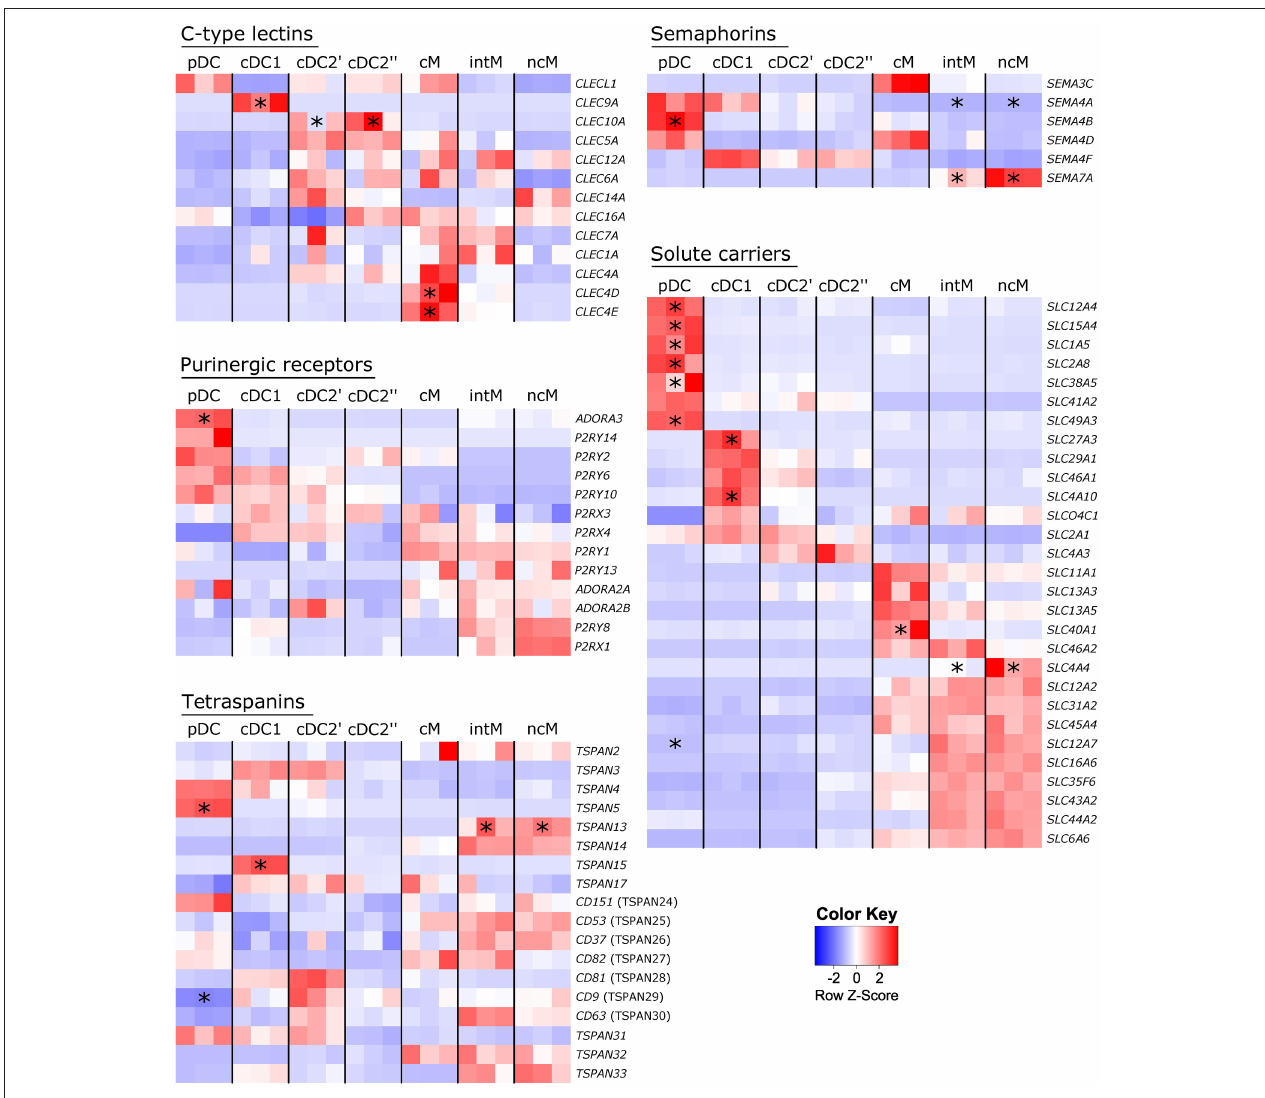
FIGURE 9 | Subset-specific gene transcription. High-throughput sequencing was performed on RNA isolated from sorted DC and monocyte subsets. Read counts are displayed as heat maps for selected molecule classes. Asterisks indicate genes at least 5-fold up-/or downregulated in certain subsets ( p < 0.05) as compared to all other subsets. Intermediate and non-classical monocytes were treated as one subset, as were cDC2 ′ and cDC2 ′′ . Complete lists of at least 5-fold up-/or downregulated genes are provided as Supplementary File 3